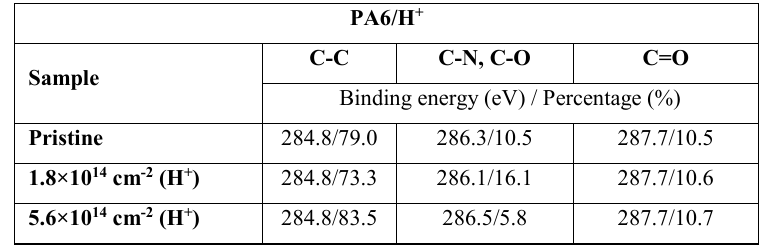
Table 5. Position and abundance of the individual components of the C 1s peak in pristine and H-ion irradiated PA6